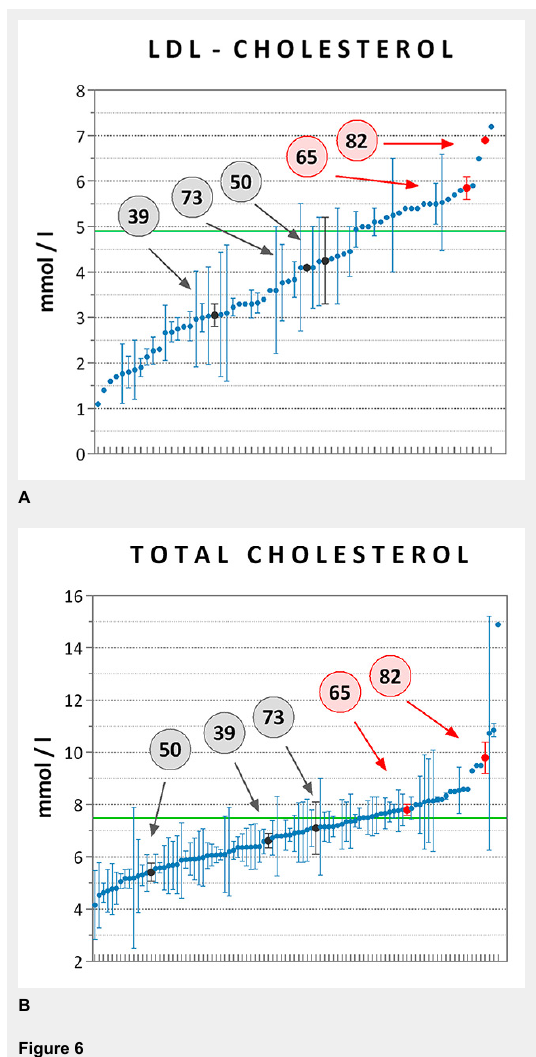
Cholesterol levels measured in carriers vs non carriers of rare, missense APOB and LDLR variants. Average LDL-C (panel A) and TC (panel B) levels were computed for each of the high-cholesterol patients tested by sequencing, irrespective of treatment. At least one value of LDL-C was available for 65 of the 94 subjects [n = 2 ± 4 data points per patient (mean ± SD)], while TC was measured at least once in all of them [n = 5 ± 6 data points per patient (mean ± SD)]. Data are presented as means ± standard error of the mean and are ranked from the lowest to the highest mean value. Data points referring to the carriers of pathogenic (patient #82) or likely pathogenic (patient #65) variants for FH are highlighted in red, while those referring to carriers of rare variants of unknown significance are highlighted in dark grey (patients #39, 73, and 50). The clinical thresholds of high LDL-C (4.9 mM) and TC (7.5 mM) are indicated by the green lines. FH = familial hypercholesterolaemia; LDL-C = low-density lipoprotein cholesterol; TC = total